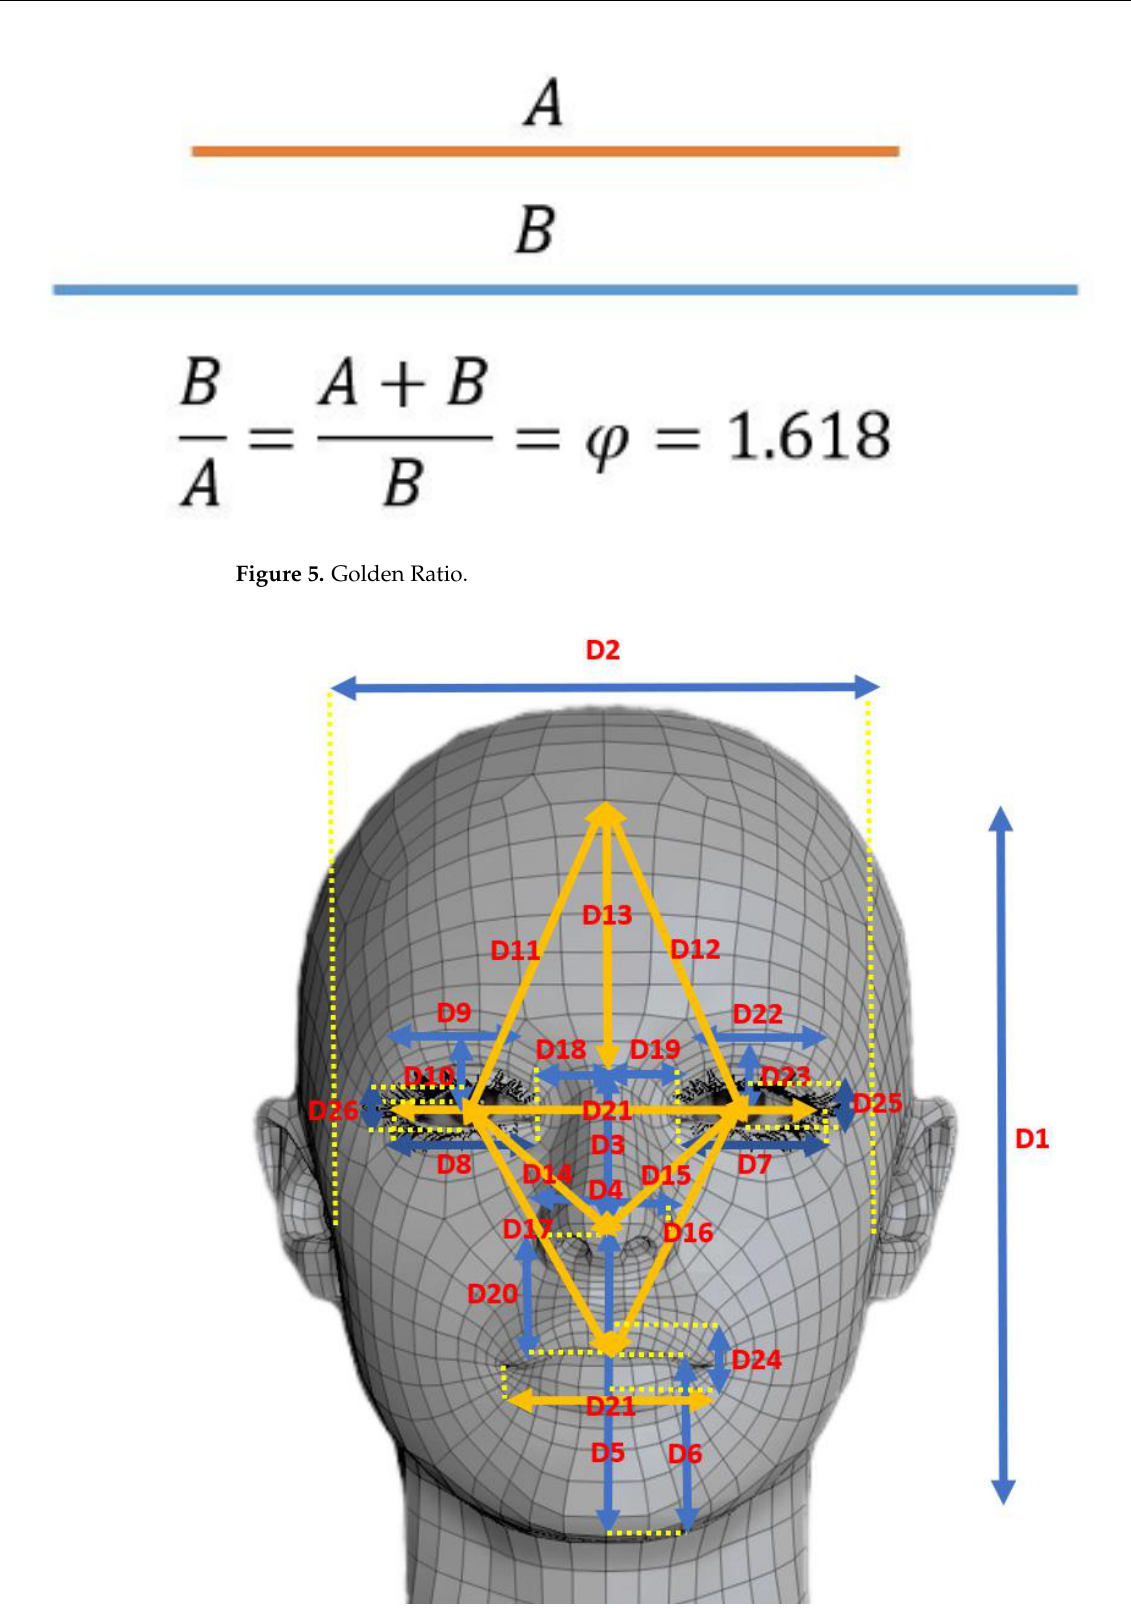
Table 3. Proposed 23 golden facial geometric features.